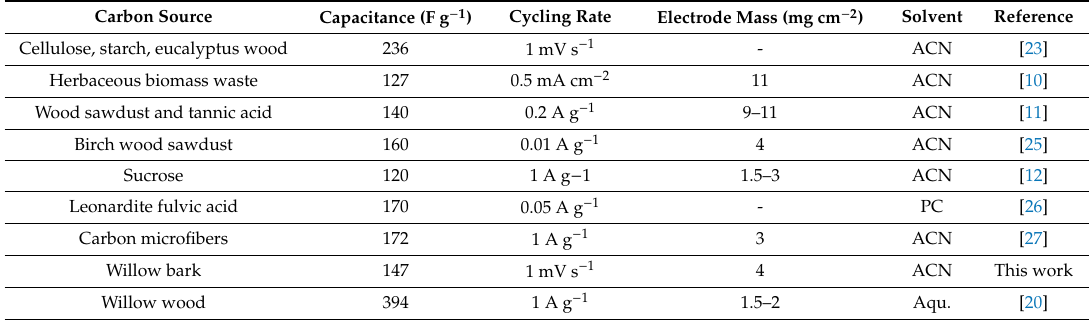
Table 1. Overview of biomaterials tested as supercapacitor electrodes. ACN: acetonitrile, PC: propylene carbonate.